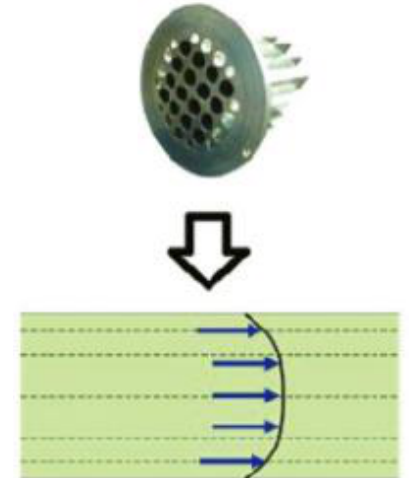
Fig. 4. Zanker-type flow conditioning plate used for fluid flow stabilization in natural gas pipelines [7].